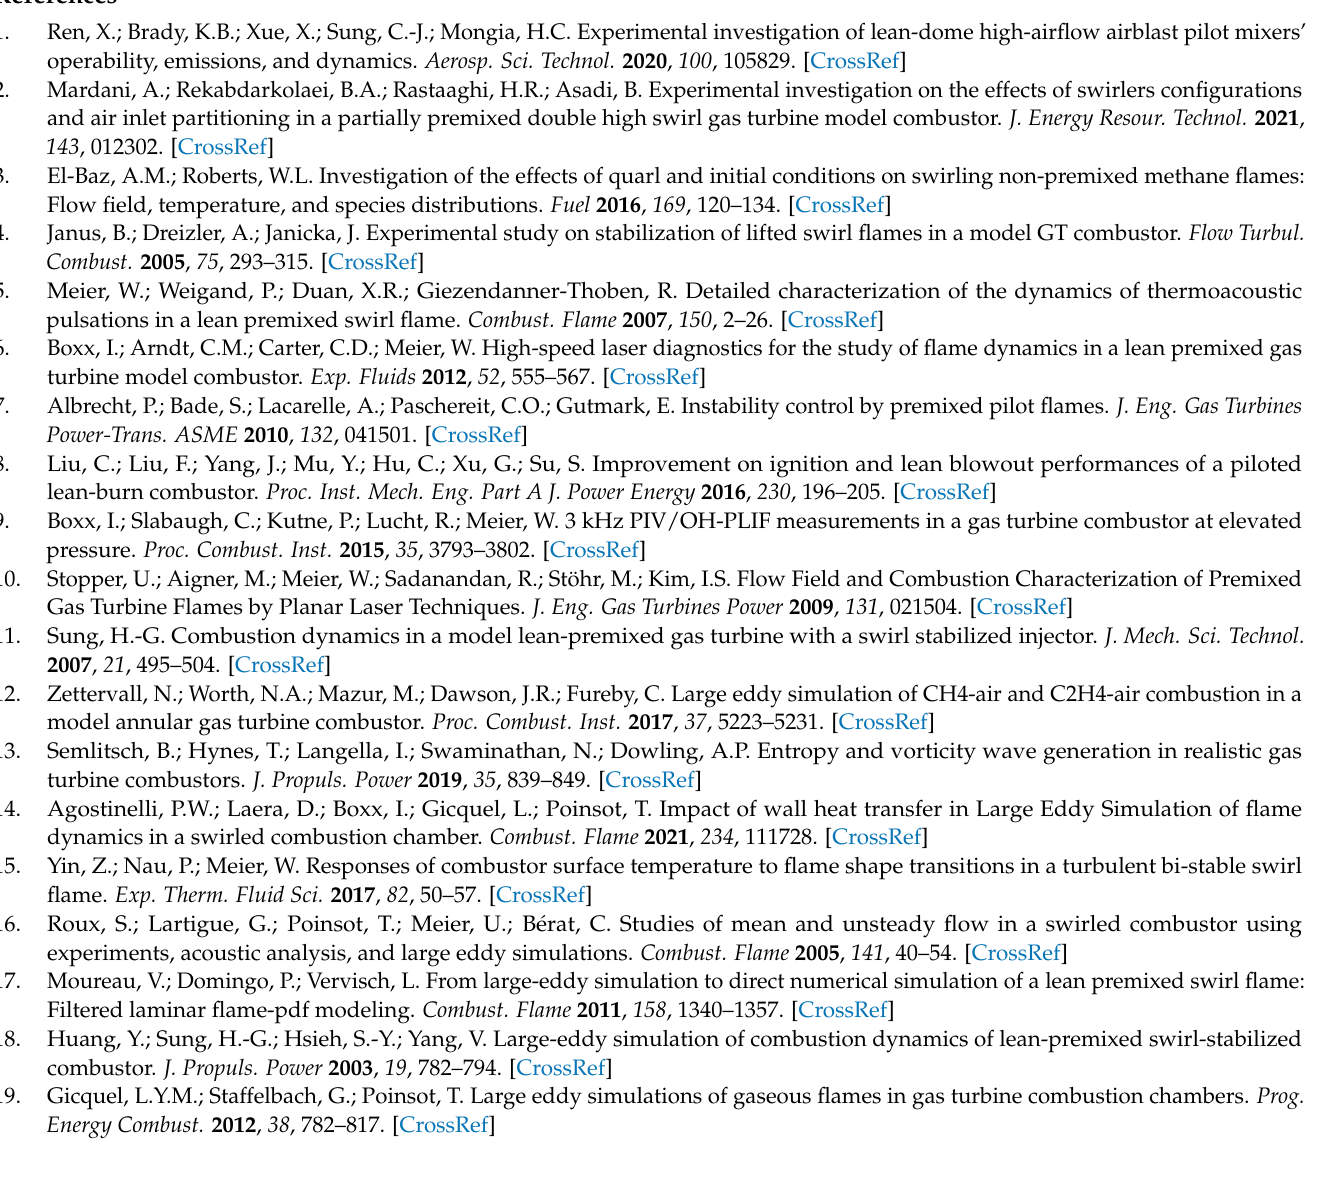
Figure A3. Mean soot volume